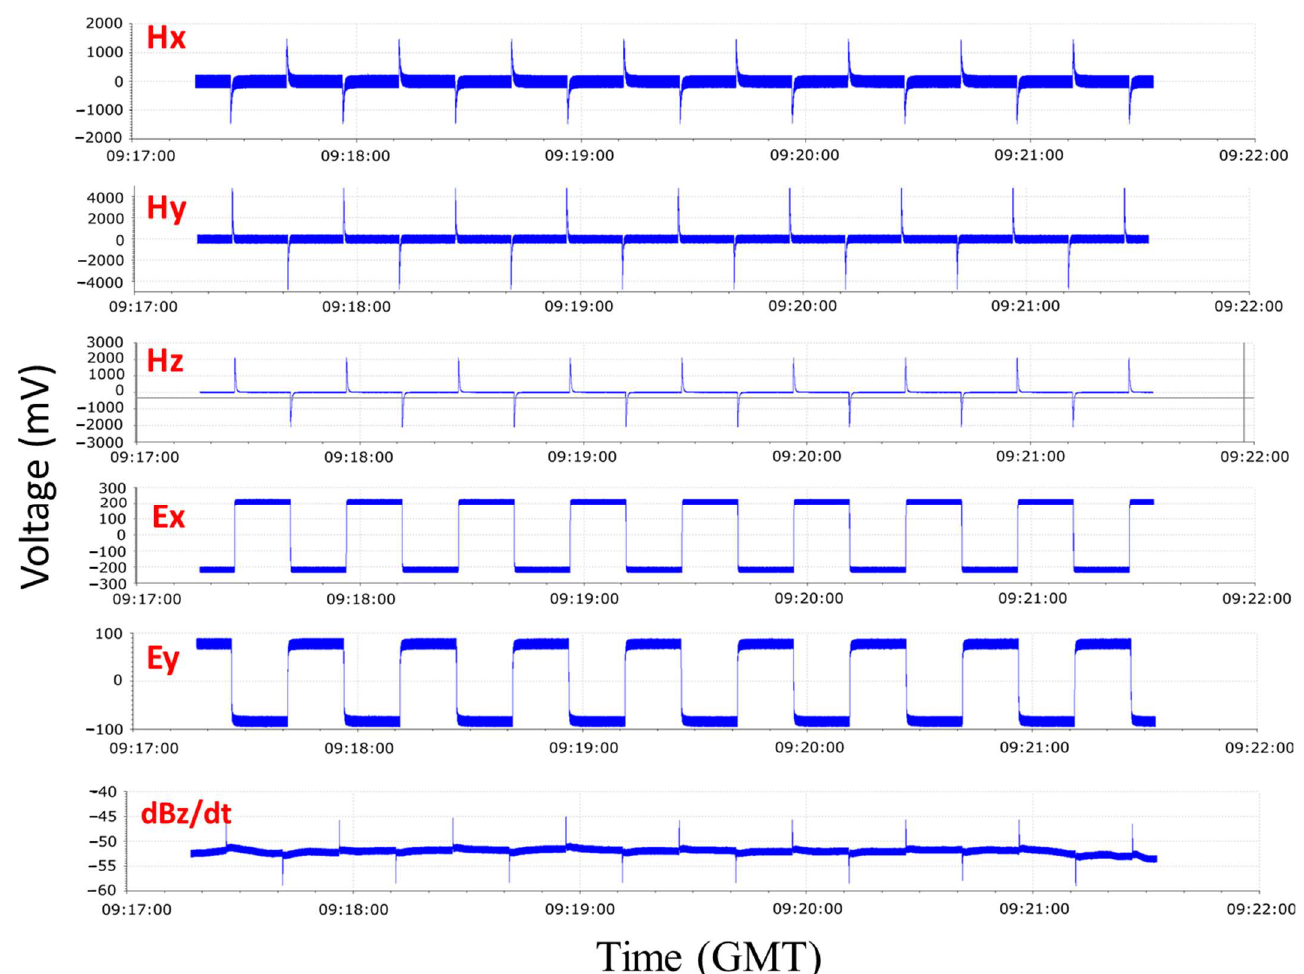
Figure 6. Data visualization in KMSProQA of the time-series (Hx, Hy, Hz, Ex, Ey, and airloop, S20) from ST-04 for a LOTEM setup with 100% duty cycle at1 kHz sampling rate.